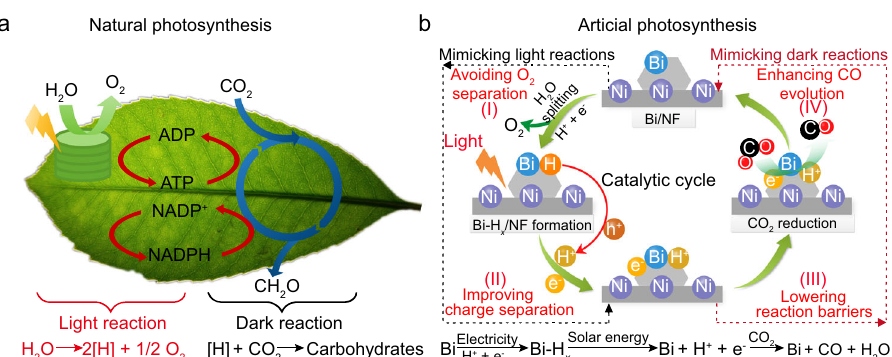
Fig. 1 Photosynthesis in nature and the arti fi cial analogy in this study. a Schematic depiction of the light and dark reactions in natural photosynthesis. b Graphical representation of the reaction pathway of the arti fi cial CO 2 reduction with the bene fi ts of the reaction model.